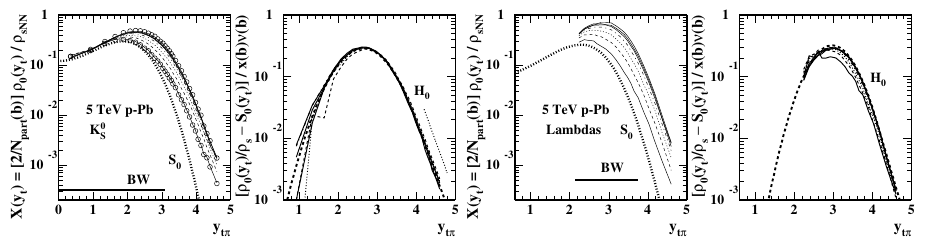
Figure 6. Spectra from seven centrality classes of 5 TeV p -Pb collisions: Left: Full spectra (first) and . Right: Full spectra (first) and isolated hard components isolated hard components (second) for K 0 S (second) for Λ + ¯ Λ . The bold dotted and dashed curves are TCM models.